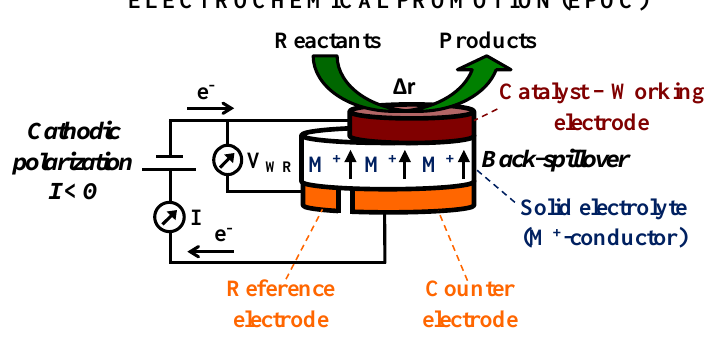
Figure 1. Scheme of the electrochemical cell used in electrochemical promotion studies with an alkaline ionic conductor (generally indicated as M + -conductor) solid electrolytes.